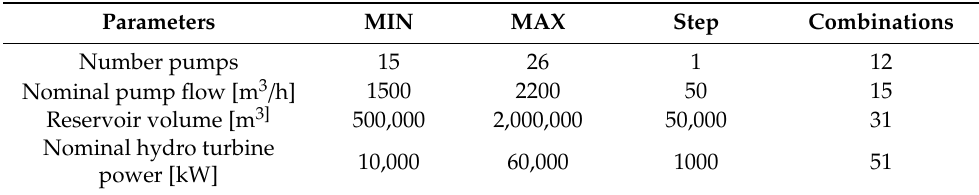
Table 3. The parameter boundaries, steps and combinations of the proposed PSP’s realization.